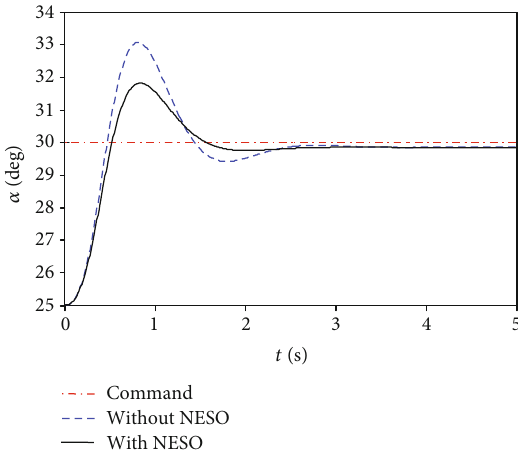
Figure 6: Angle of the attack tracking diagram.